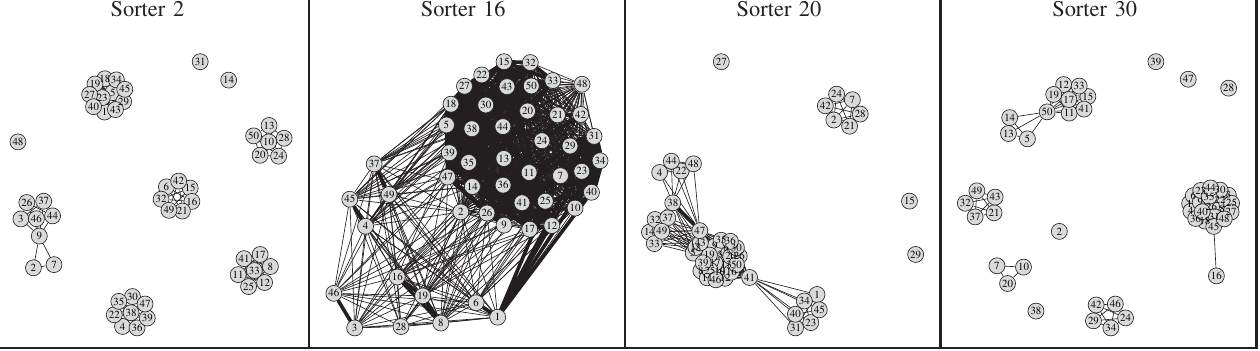
FIG. 2. MSU physics study sorter graphs. Displayed from left to right are the categorization graphs for representative sorters. Sorters 2 and 16 were experts and sorters 20 and 30 were novices. Sorters 2 and 30 did very little multiple categorization, sorter 20 did a good bit of multiple categorization. Sorter 16 was unique in choosing to categorize each problem between 2 and 3